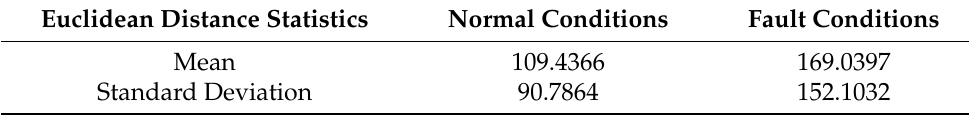
Table 8. 1000 Ω fault